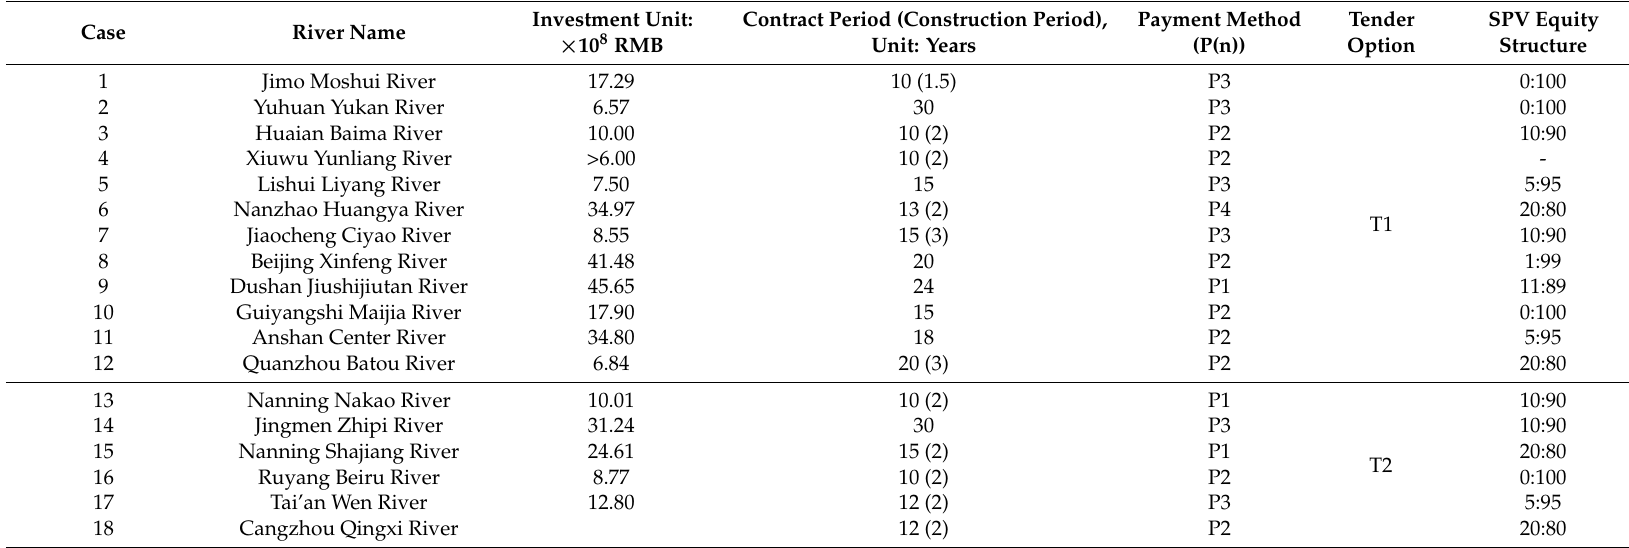
Table 2. The information of cases in this